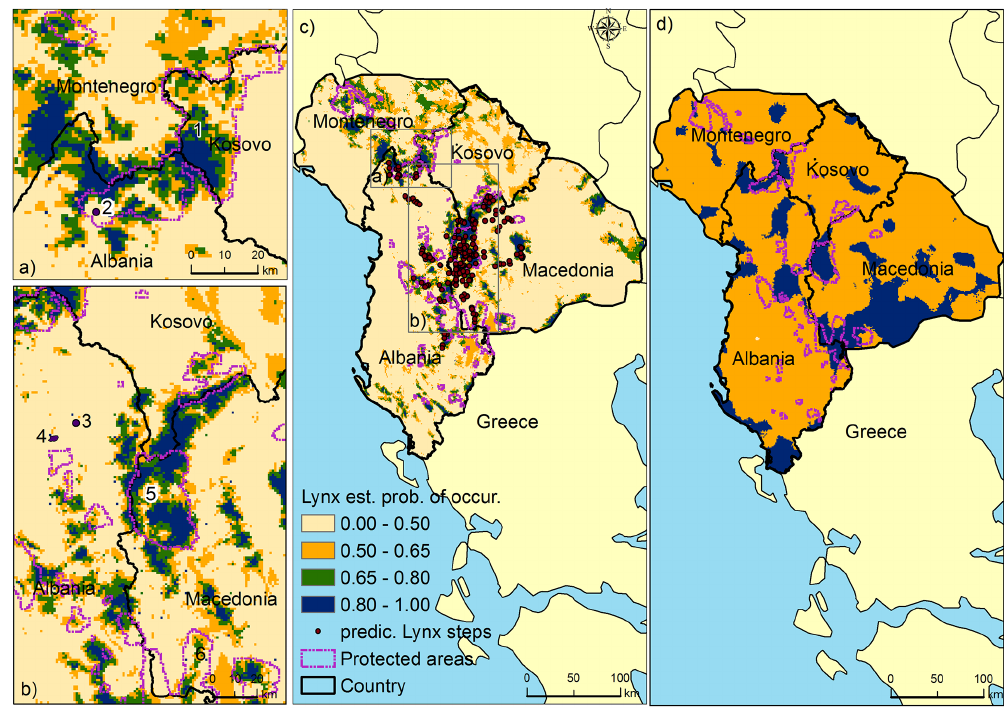
Figure 2. The estimated probability of occurrence of the lynx (a) in the cross-border area of Montenegro, Albania, and Kosovo, (b) in the cross border area of Albania, Macedonia, and Kosovo (c) model 1 (biological feature used in Zonation), (d) model 2 (cost layer used inverted in Zonation) and existing terrestrial protected areas. The numbers (1), (2), (3), (4), (5), (6) identifies approximately areas of the lynx photos captured in Kosovo (in year 2015), 27 and 21 photos in Albania (in year 2014 and in winter time between 2014 and 2015, respectively) and 37 photos (in 2015) in (5) and photos in (6) (in year 2013) in Macedonia, respectively. These areas are approximately selected by using Google Earth 2015 and village geographical data of